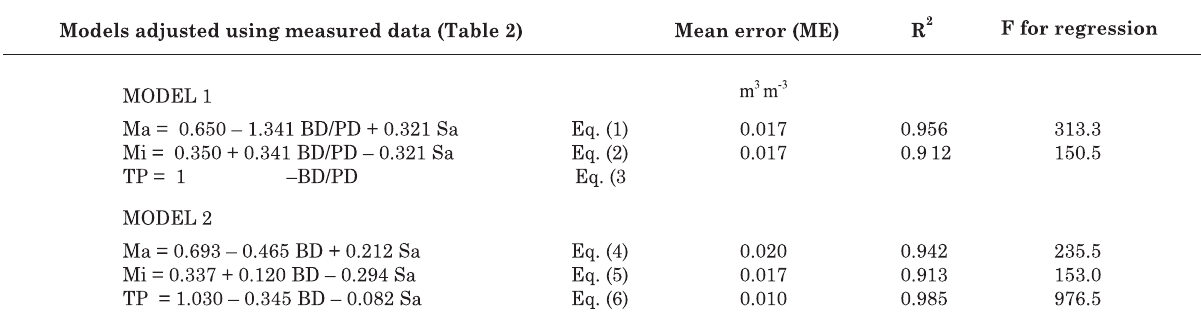
Table 3. Statistical results for model